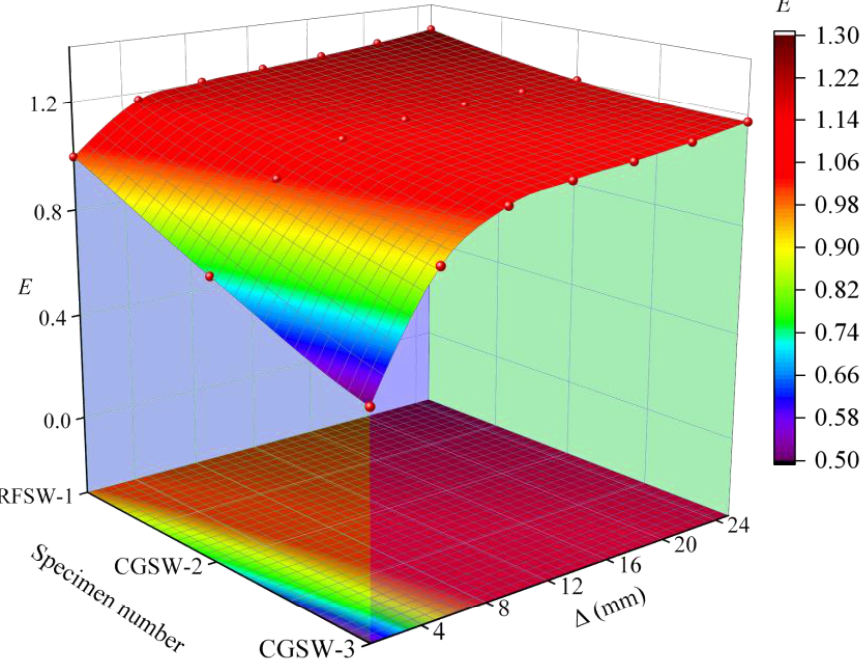
Figure 16. Energy dissipation coefficients of the specimens.